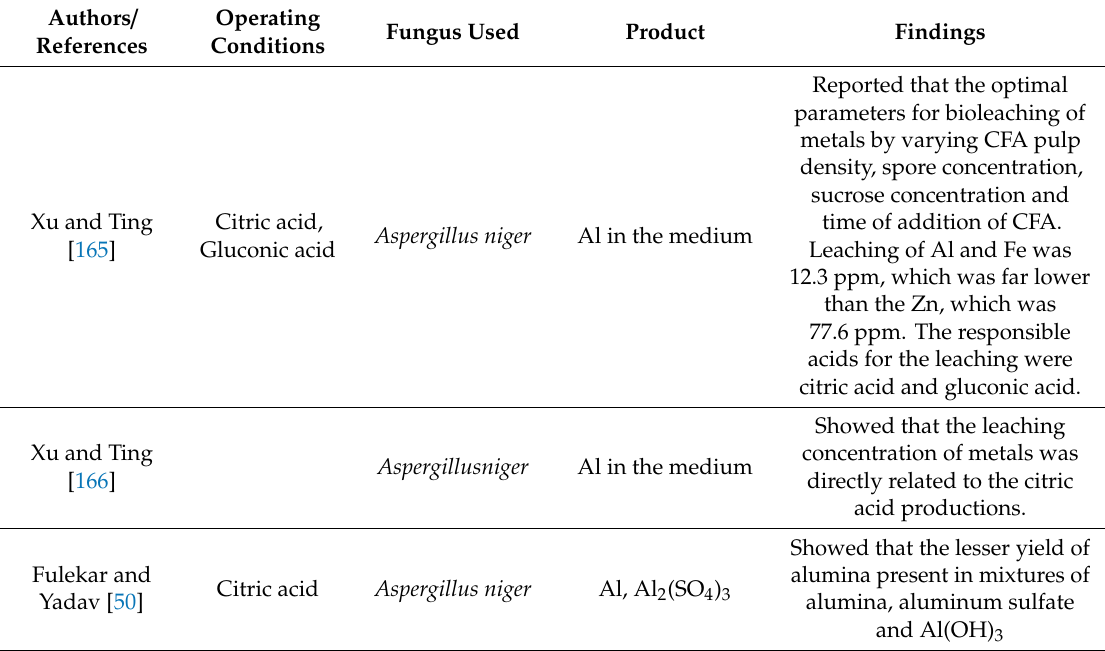
Table 5. Aluminum leaching by from fly ash by fungi.